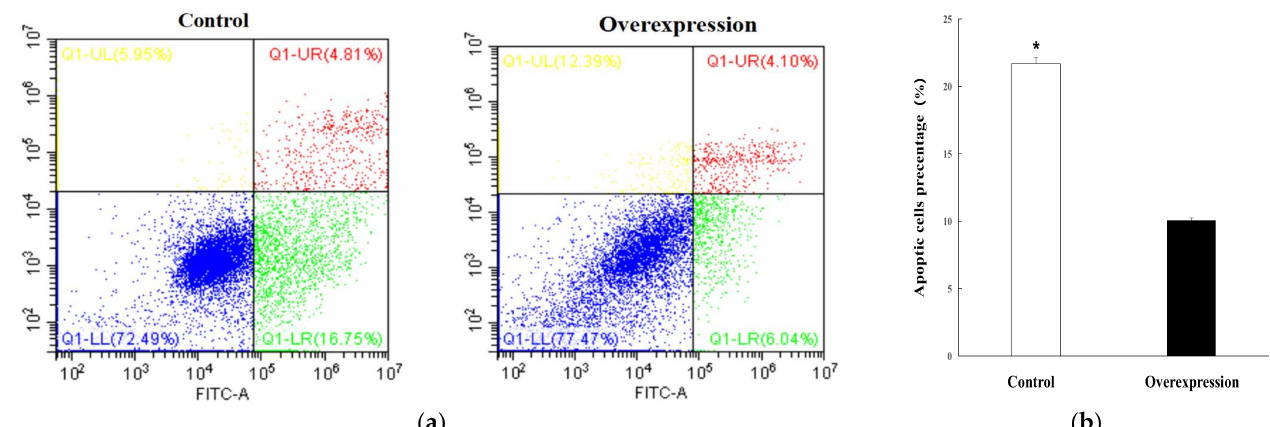
Figure 8. The effects of lnc_000884 overexpression on IPEC-J2 cell proliferation by MTT assay. The data from three independent experiments was shown as means ± SEM. * p < 0.05.